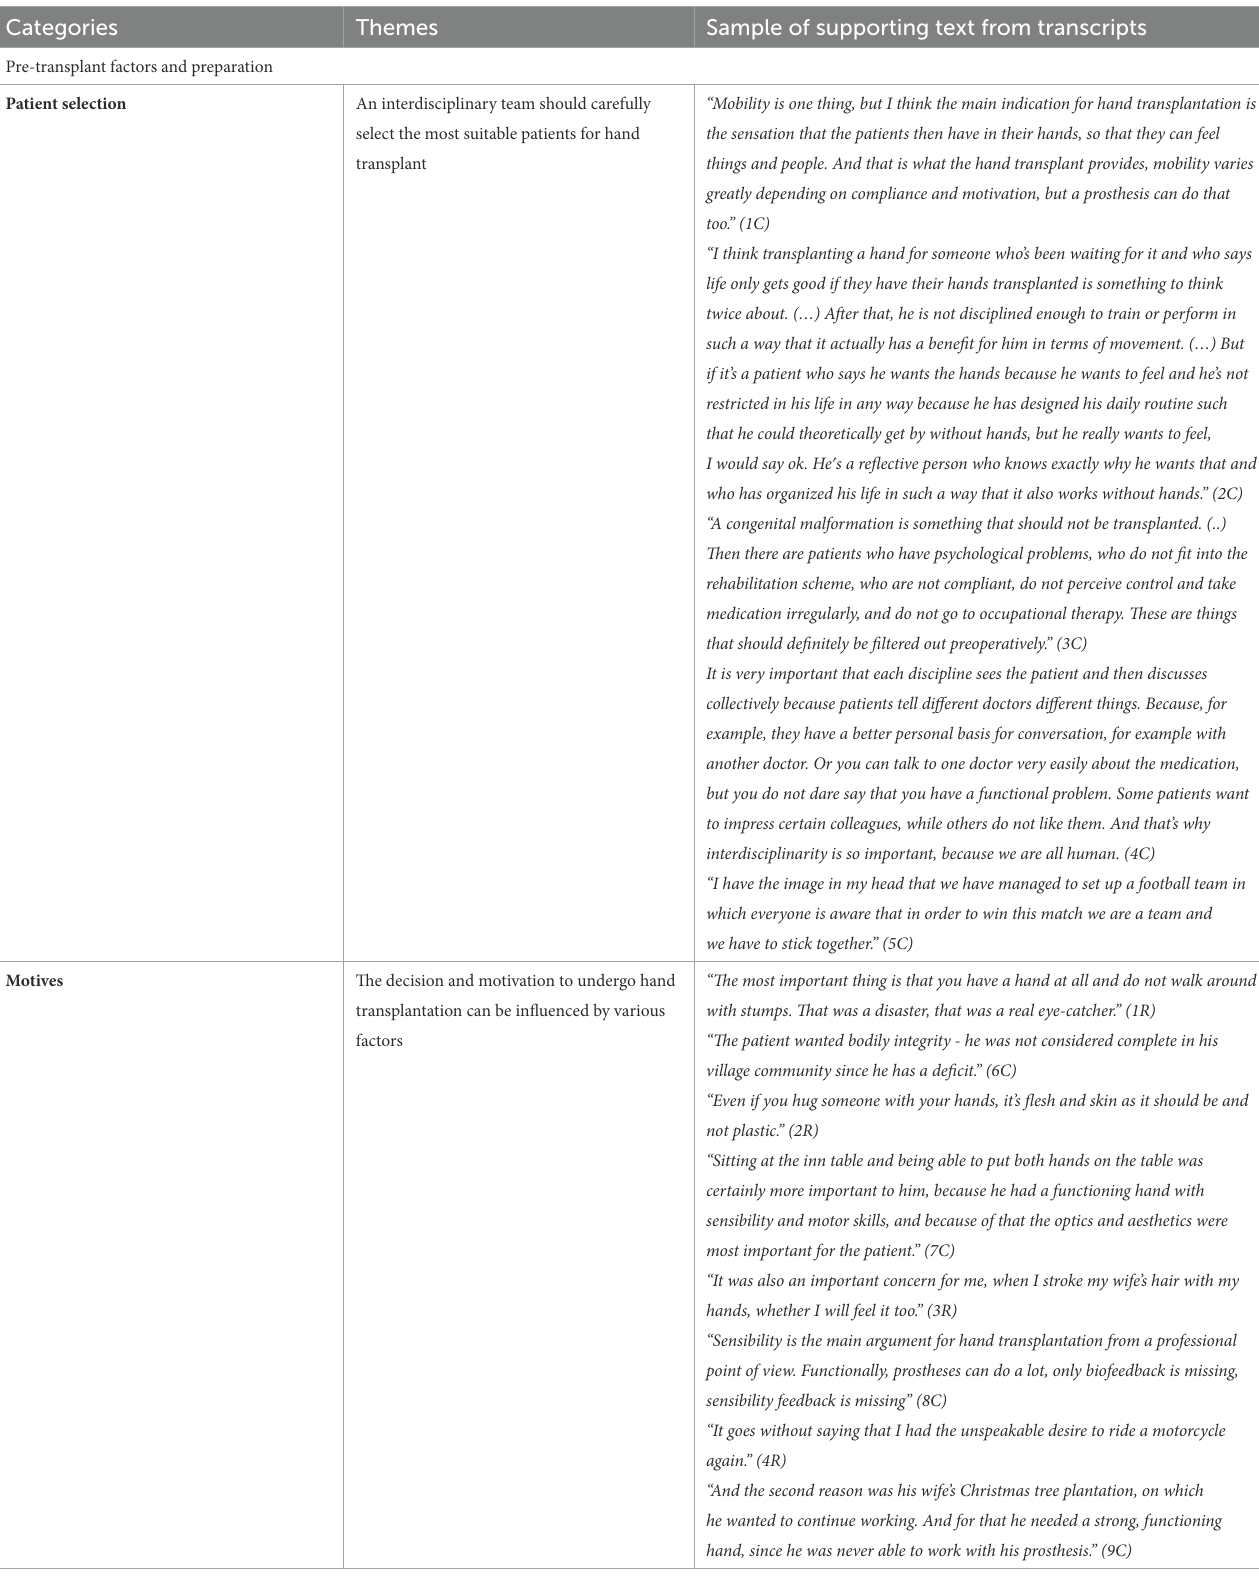
TABLE 1 Categories and themes from the thematic map, associated hypotheses and supporting quotations from the interview